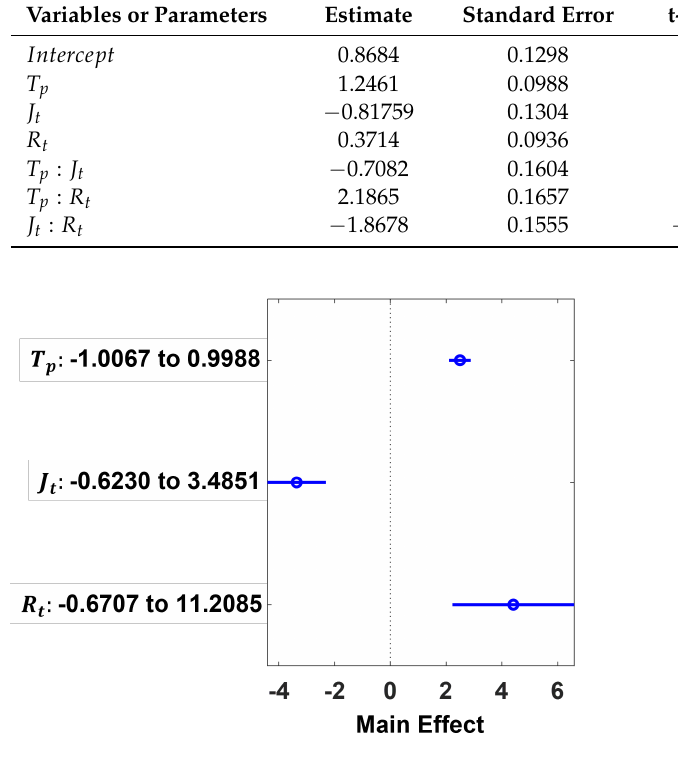
Figure 10. Main effect: T p , J t , and R t metrics for all the SDN